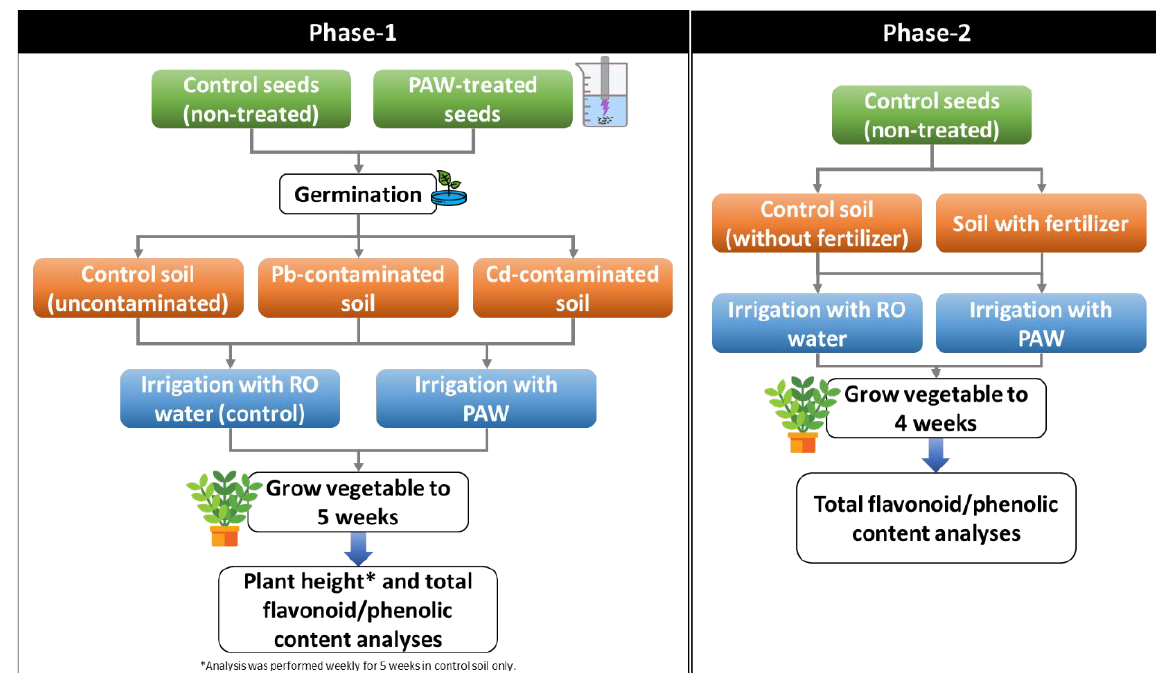
Figure 2. A schematic diagram of the Phase-1 and Phase-2 pot experiments.